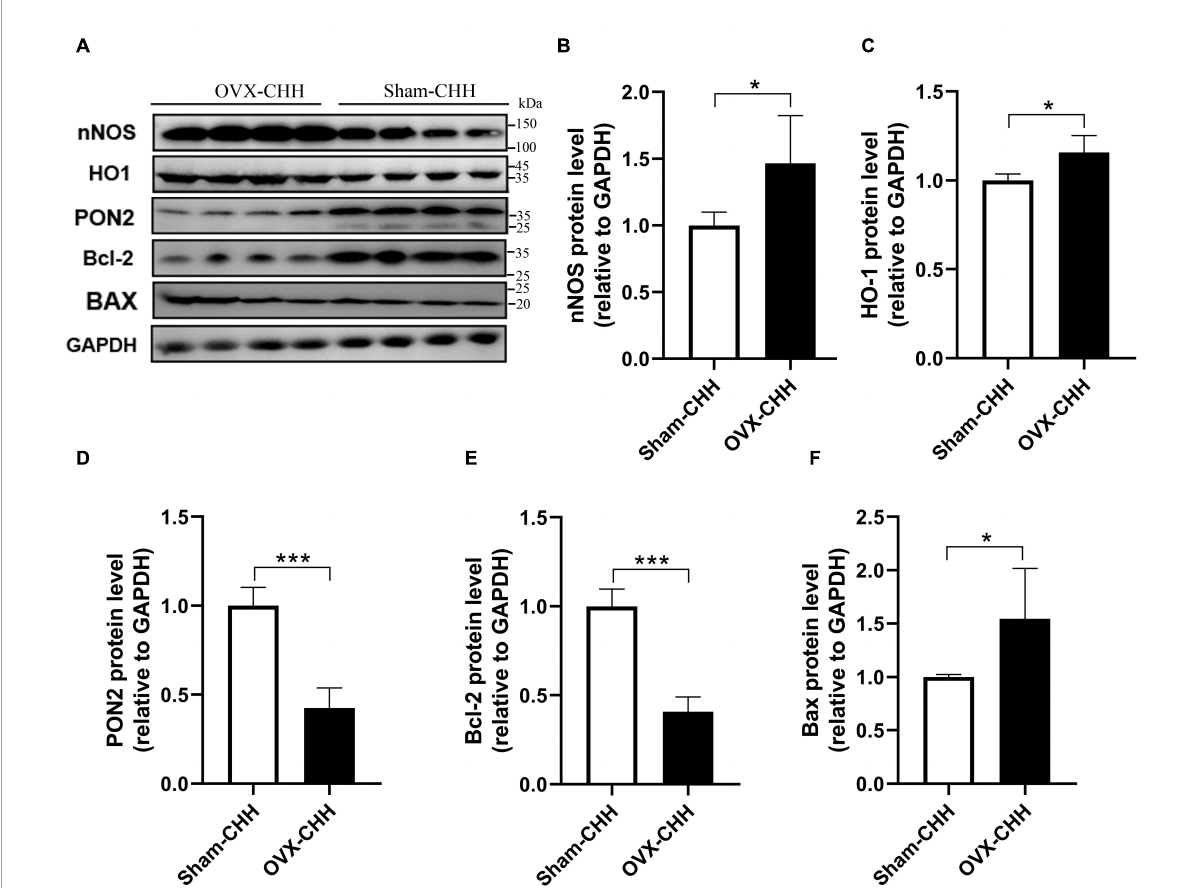
FIGURE13 Effects of OVX on PON2, nNOS, HO-1, Bcl-2, and Bax protein expression in the hippocampus of female CHH rats. (A) Representative western blot images of nNOS, HO-1, PON2, Bcl-2, and Bax proteins, 30 µ g/lane. (B–F) Quantitative analysis of relative optical density and comparison between groups. Values are means ± SD for four animals/group. Compared with sham CHH, * p < 0.05, ** p < 0.01, *** p <